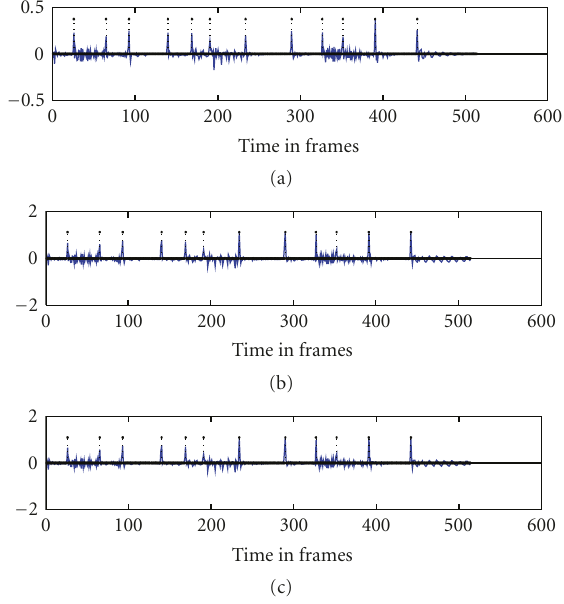
Figure 15: Comparison between the detection functions for the real piano signal (see Figure 7). Plots (a), (b), and (c) are detection ( k ), h o ( k ), and h o ( k ), respectively, where the detected functions h o a r b onsets using these functions are marked with